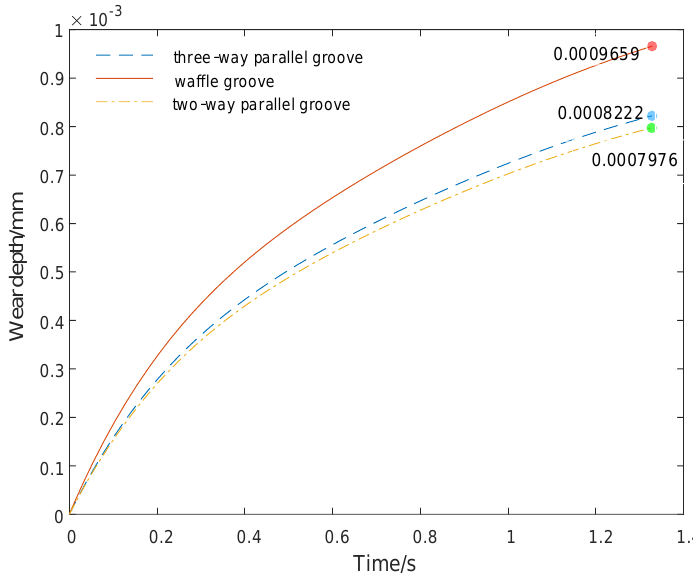
Figure 8. The wear depth with three different groove shapes.